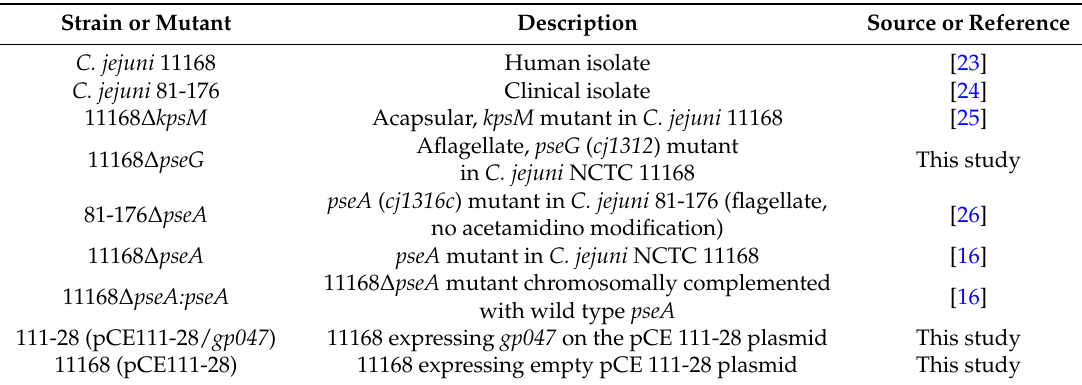
Table 2. List of bacterial strains and mutants used in this